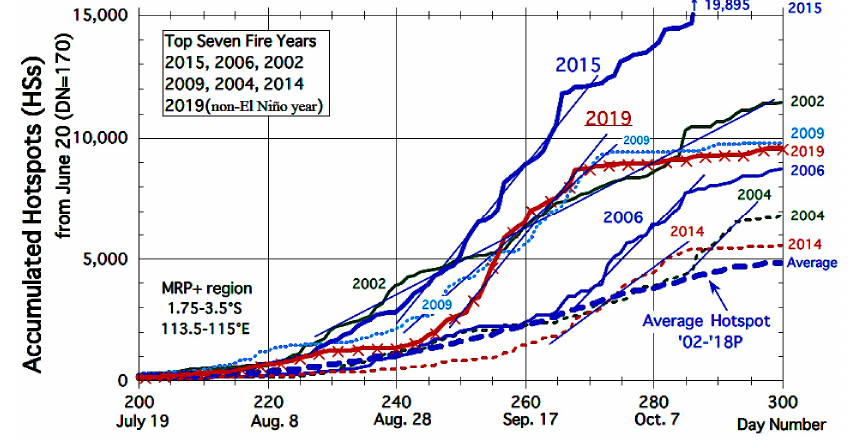
Figure 7. Trends for the seven fire years.